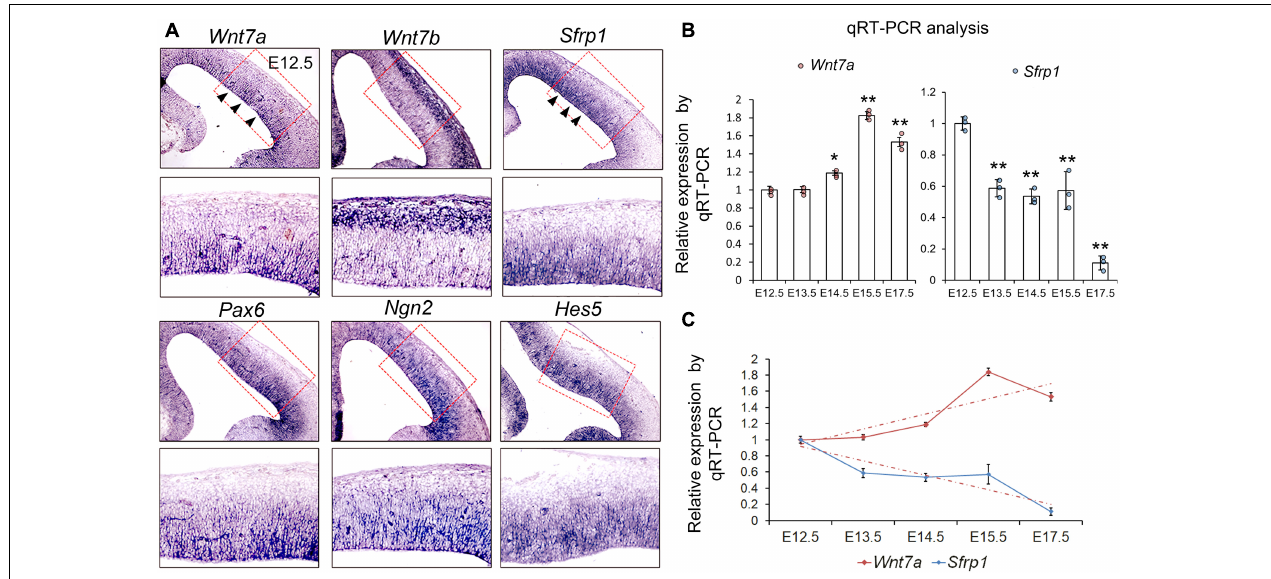
FIGURE 1 | Wnt7a and Sfrp1 are co-expressed in neural progenitors and show opposite expression trends. (A) In coronal sections of mouse E12.5 cerebral cortices, Wnt7a , Sfrp1 , Pax6 , Ngn2, and Hes5 were expressed in the ventricular zone (arrowheads). Conversely, Wnt7b was expressed in newborn neurons. Red boxes show high power views. (B) qRT-PCR analysis of Wnt7a and Sfrp1 expression levels at different embryonic stages (E12.5, E13.5, E14.5, E15.5, and E17.5). All comparisons were made with that of values at E12.5. Values of histogram represent mean ± SEM, and each dot represents a data point in each biology repeat ( n = 3, ∗ P < 0.05; ∗∗ P < 0.01; unpaired Student’s t -test). (C) Opposite expression trends between Wnt7a and Sfrp1 at different embryonic stages (from E12.5 to E17.5) measured by